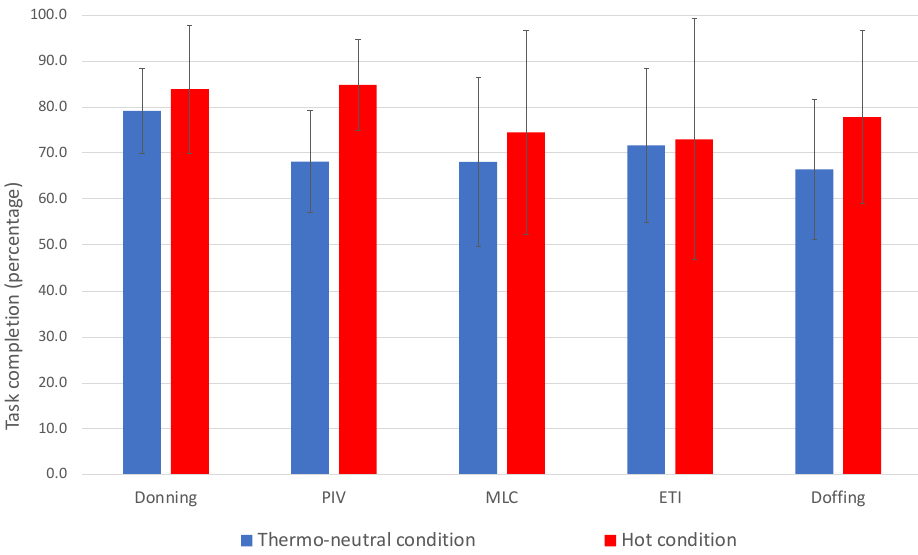
Figure 4. Comparison of the mean percentages of completed tasks between the hot ( n = 10, red bars) and thermo-neutral ( n = 8, blue bars) conditions. Data are missing for one participant for ETI and doffing (hot condition). Differences were non-significant for donning ( p = 0.14), midline catheter (MLC) insertion ( p = 0.46), endotracheal intubation (ETI) ( p = 0.60), and doffing ( p = 0.19) and significant for peripheral IV (PIV) insertion ( p = 0.015).